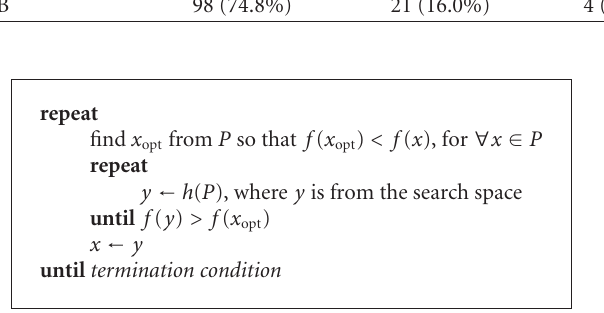
Algorithm 1: Generate population P = x n , that is, N random points from the search space X